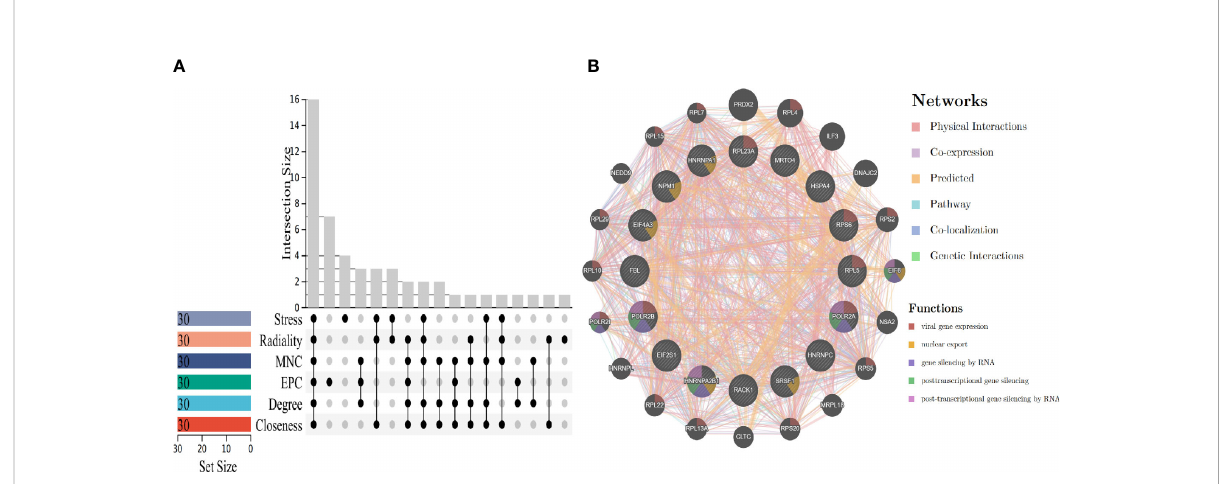
FIGURE 5 Hub genes screening and gene co-expression analysis. (A) Hub genes screening by using six algorithms. (B) Hub genes co-expression and functional enrichment